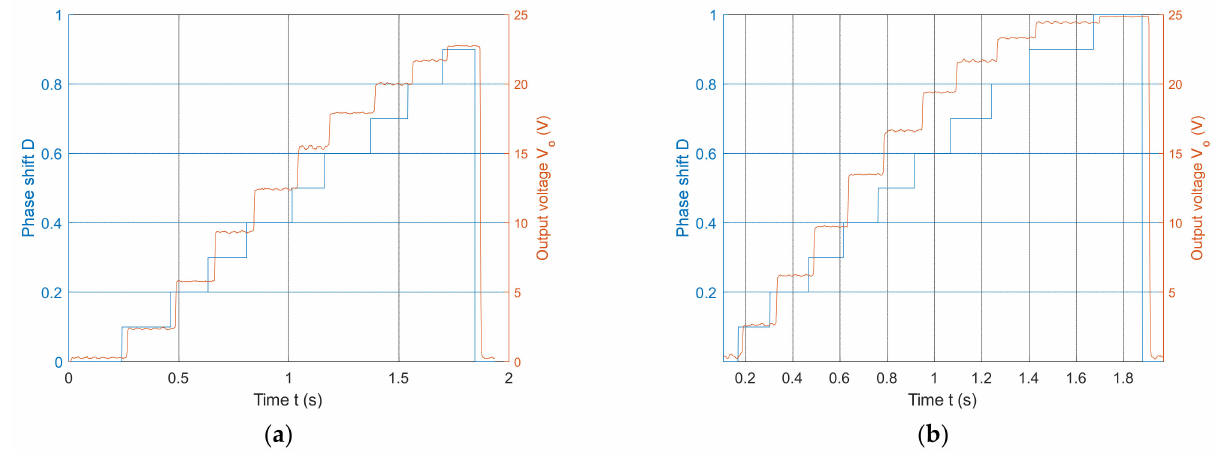
Figure 11. System step response to change of phase shift. ( a ) DD1 part of the IPT system, ( b ) DD2 part of the IPT system.